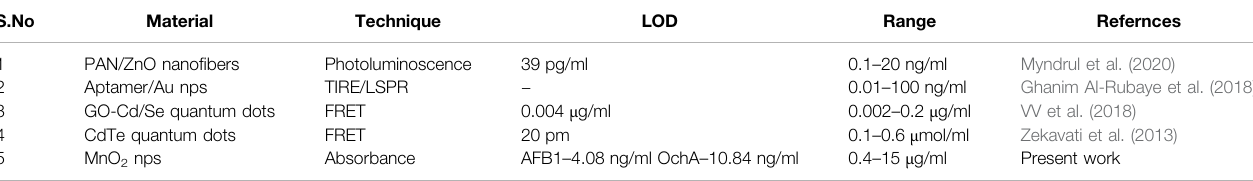
TABLE 1 | Summary of sensing performance in comparison to reported